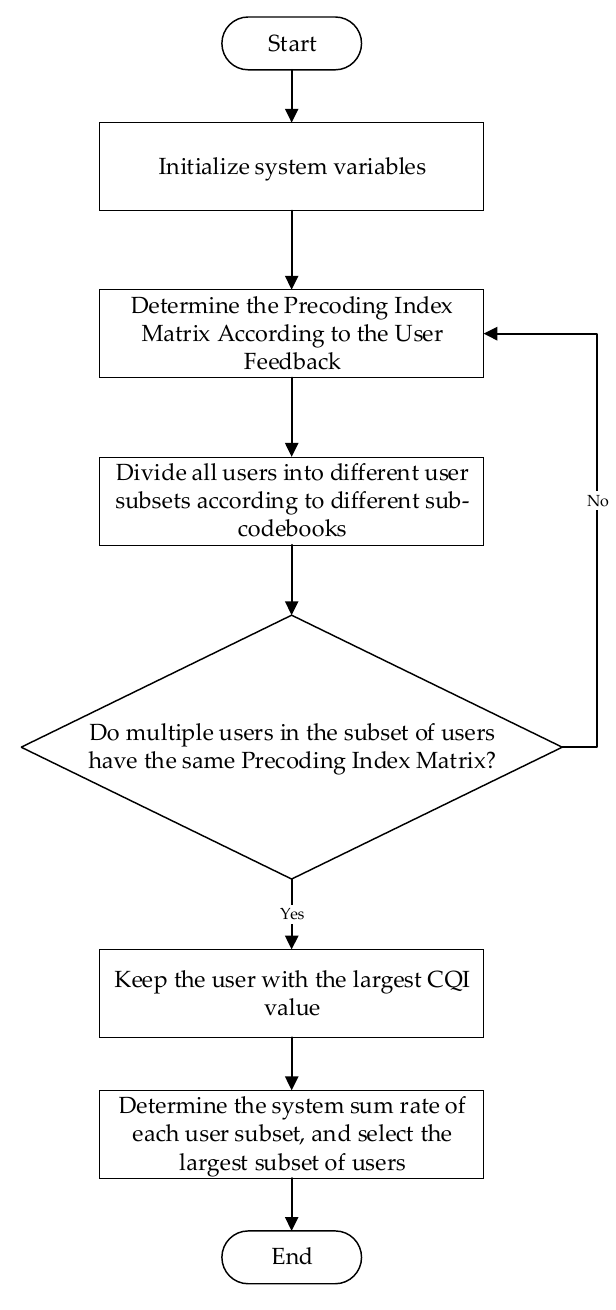
Figure 3. Flowchart of the proposed 3D-MIMO codebook.